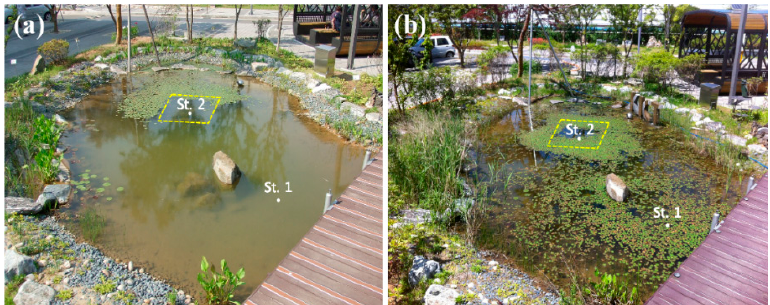
Figure 2. Installation of the ADP at the study site. St. 1 and St. 2 are placed in the areas of open space and ADP, respectively. Photo ( a ) is a view of the pond in May 2012 and photo ( b ) is a view of the pond in May 2013.